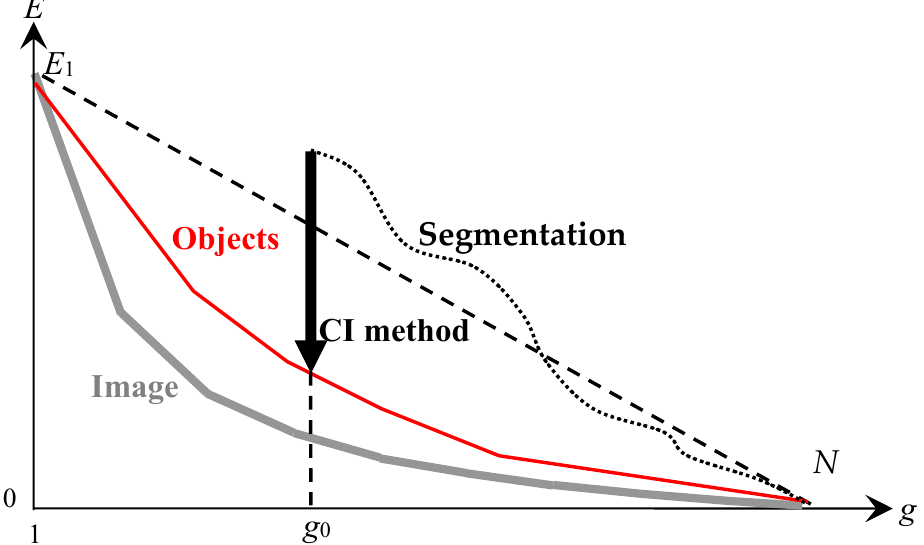
Figure 9. The CI method for minimizing the approximation error with the same number of clusters in the image approximation. The limiting lower gray curve, which is assumed to be predominantly convex, describes the optimal image approximations. The upper dotted curve describes the generation of some approximation of the image, specifically, by hierarchical segmentation. The intermediate convex red curve describes the resulting hierarchy of approximations obtained by the CI method in combination with Ward’s method.